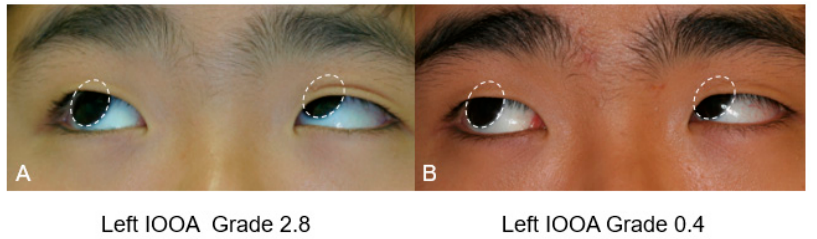
Figure 1. Objective analysis of left inferior oblique overaction (IOOA) in a patient looking at the upper rightward direction before ( A ) and after ( B ) surgery. The corneal contour of both eyes were extrapolated from nine-gaze photographs. The curved line of the corneal margin that is visible from the original photograph was transcribed (dashed line) and a full ellipse was extrapolated so the corneal contour can be drawn for photographic analysis [12]. Table 2. Oblique muscle dysfunction before and after inferior oblique myectomy accompanied with Tenon’s capsule closure in the operated eye and contralateral